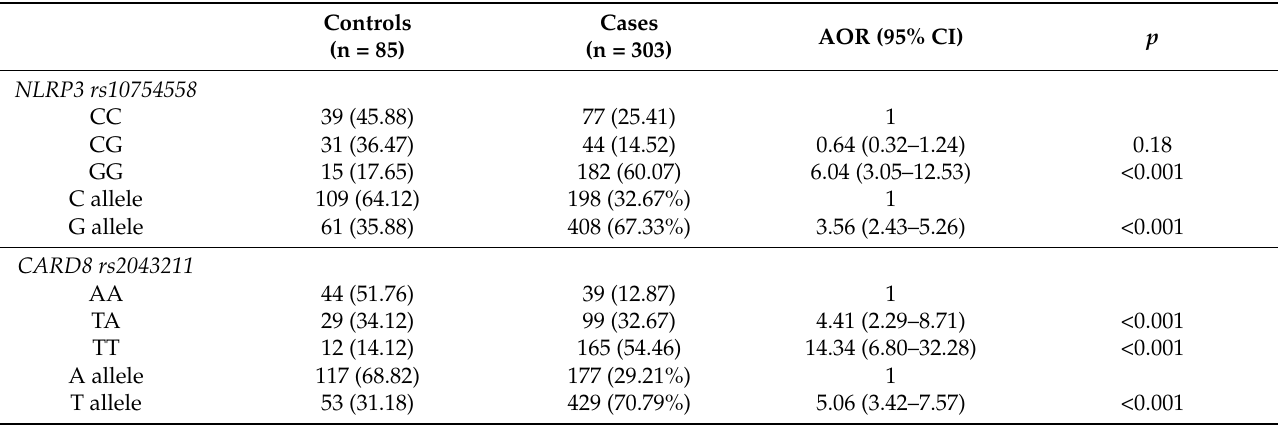
Table 2. Genotype and allele frequencies of NLRP3 rs10754558 and CARD8 rs2043211 in cases